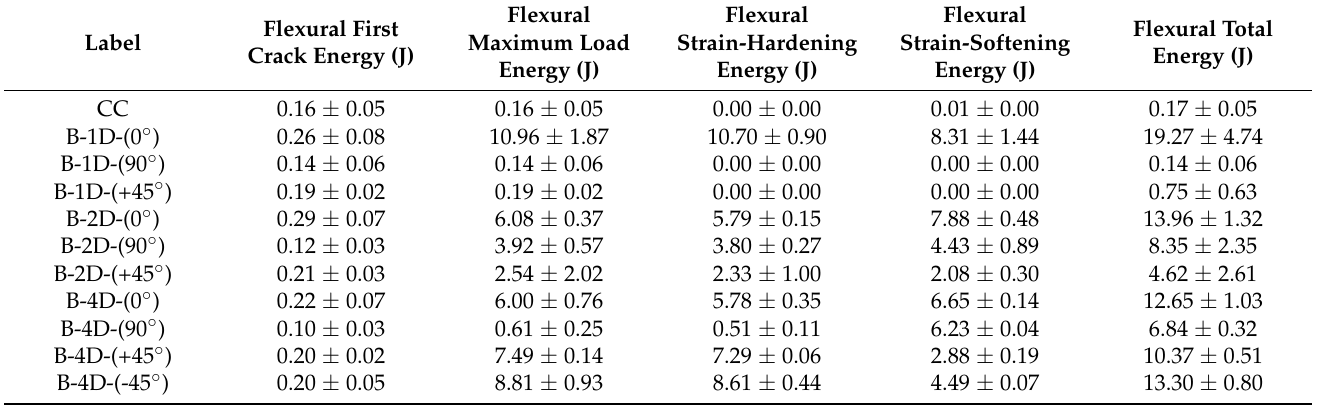
Table 5. Average flexural energy results in various stages of multiaxis 3D basalt fiber concretes.